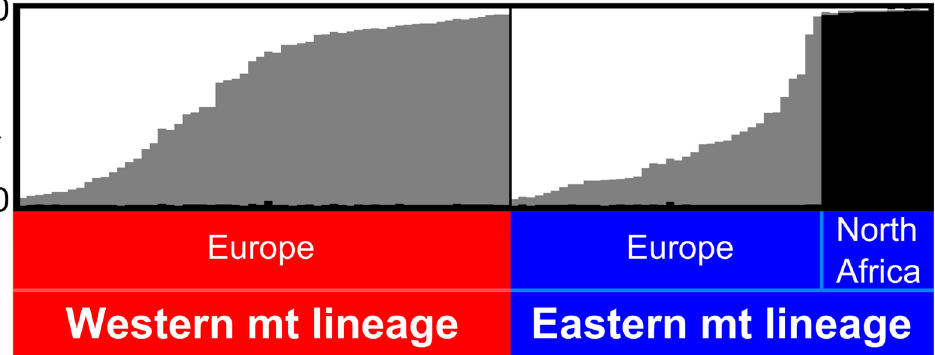
Fig 5. Population structure inferred for K = 3 by the Bayesian clustering analysis. The analysis was performed from alleles at five microsatellites for 111 P . kuhlii . An admixture model was used and 20 independent runs of S TRUCTURE were performed in order to calculate a mean membership (Q-value) for each individual. Individuals are represented by vertical bars and sorted by mitochondrial